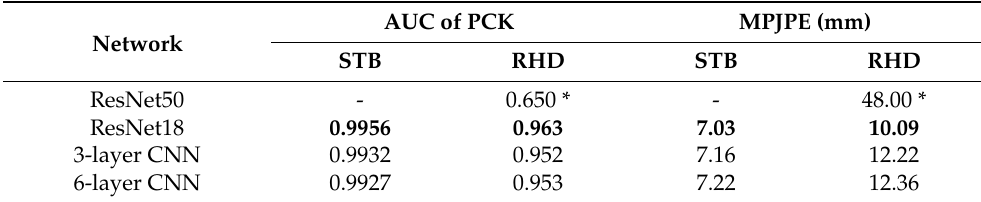
Table 5. Effectiveness of the depth network